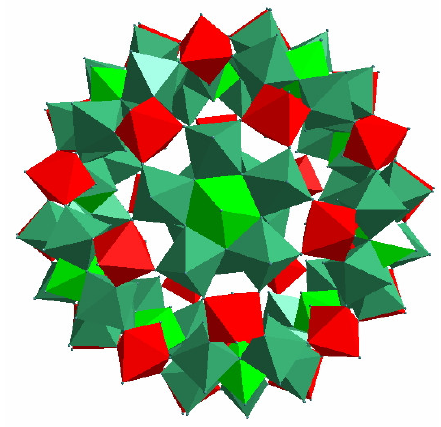
Figure 1. Polyhedral representation of 1 with red and green representing FeO 6 and MoO 6 octahedra, respectively.